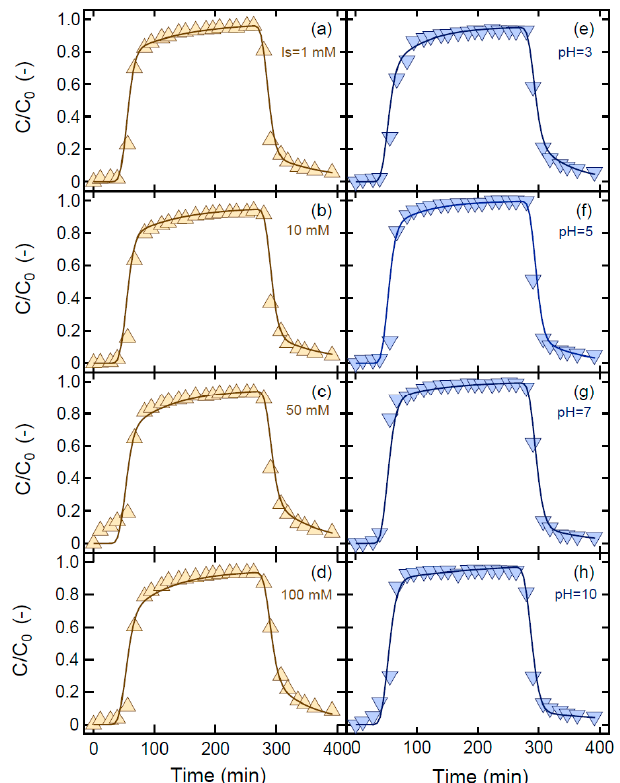
Figure 3. TM normalized breakthrough concentrations (symbols) at four different Is values ( a – d ) and four different pH values ( e – h ) collected at the exit of the water-saturated columns packed with quar tz sand, together with the best fi tt ed model simulations (solid curves).